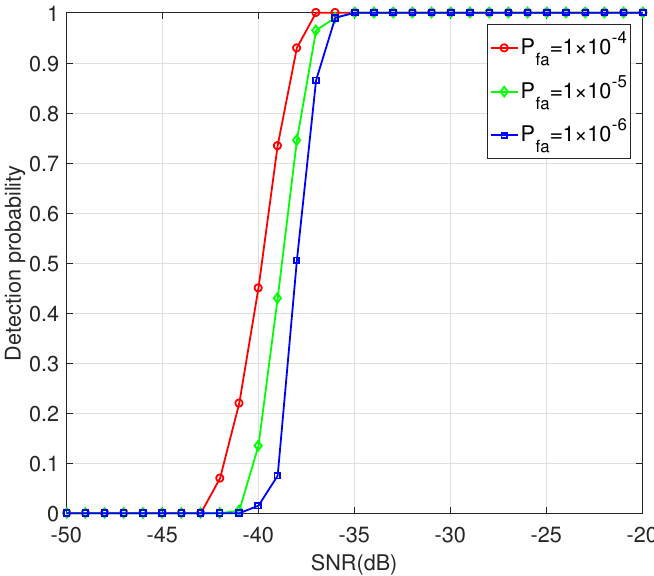
Figure 13. Sensing performance with different false alarm